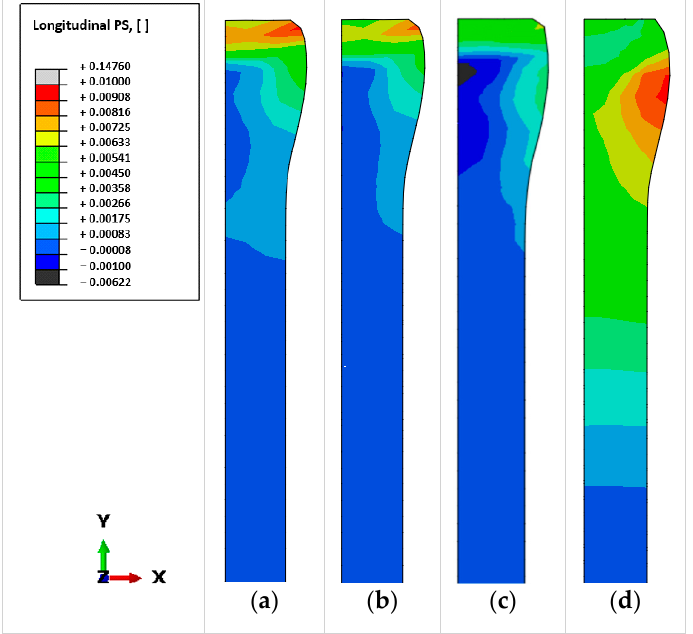
Figure 9. Longitudinal plastic strain (PS) distribution on the inspection plane: ( a ) large scale implicit transient model (control model); ( b ) short implicit transient model; ( c ) short explicit transient model; ( d ) Eulerian steady-state model.